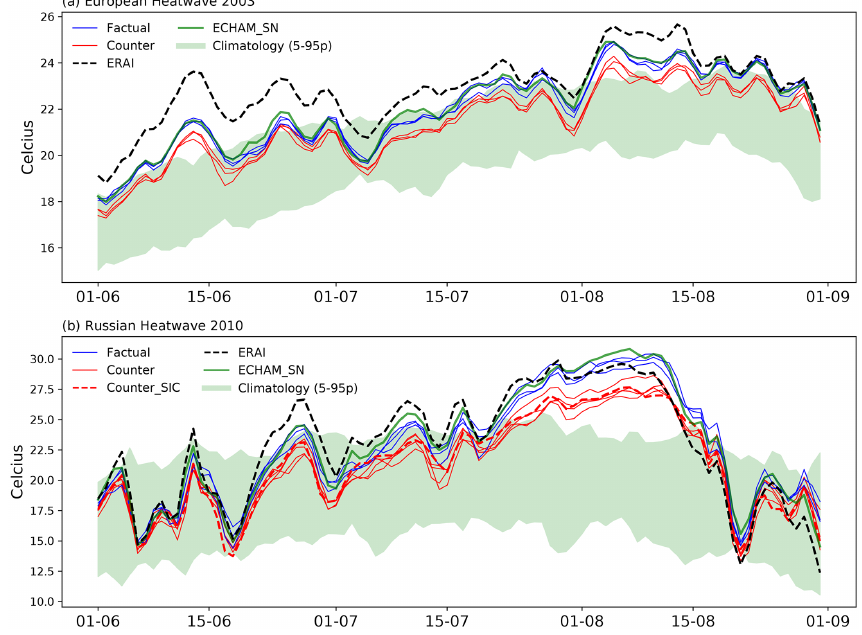
Figure 5. Daily mean temperature at 2m height [ ◦ C] averaged over (a) Europe (35–50 ◦ N, 10 ◦ W–25 ◦ E) for summer 2003 and over (b) Rus- sia (50–60 ◦ N, 35–55 ◦ E) for summer 2010 for the factual (blue), counterfactual (red), and ECHAM_SN (green) simulations and ERA- Interim (dashed black) reanalysis data. The climatology (green shaded area) is the 5th–95th ranked percentile range between 1985–2015 calculated with ECHAM_SN (Schubert-Frisius et al., 2017). The dashed red line in (b) shows the simulation with SIC changed in one of the counterfactual simulations (see text for